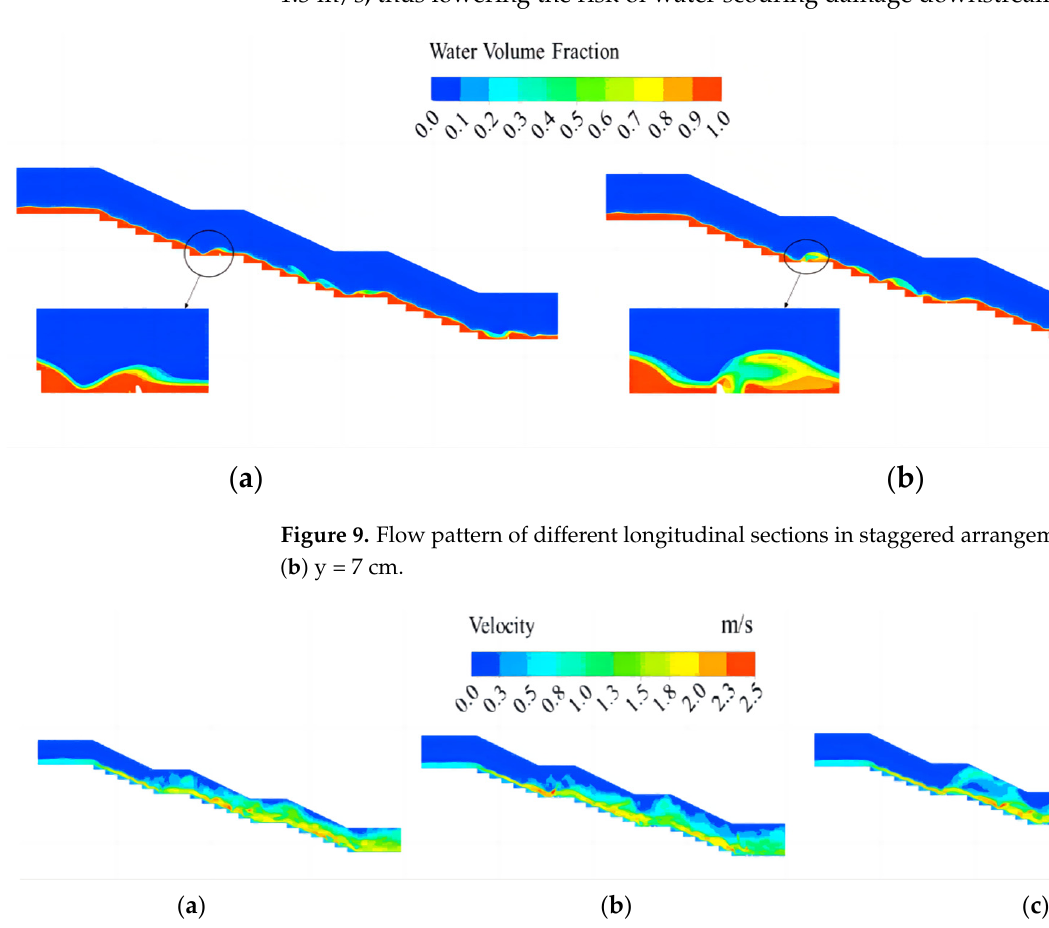
Figure 10. Flow velocity diagram of each body type step section at Q = 30 m 3 /h. ( a ) Traditional steps, ( b ) double-row arrangement, and ( c ) staggered steps.